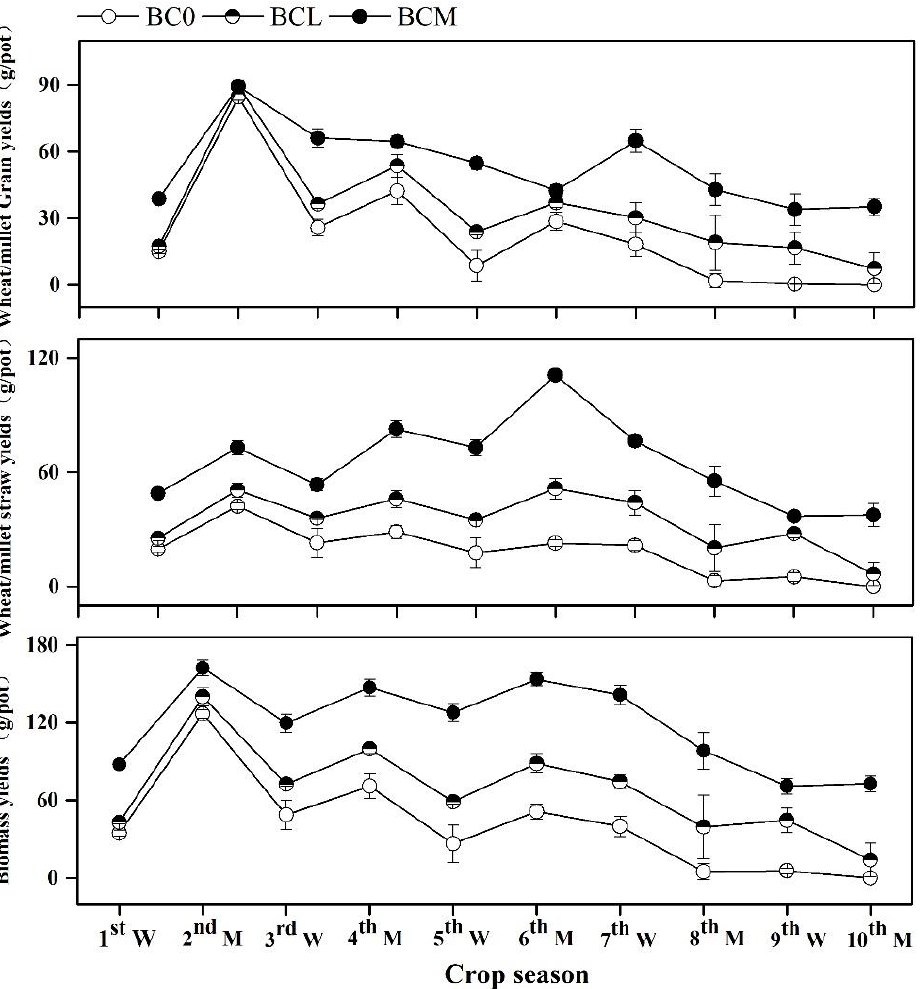
Figure 6. The yields of grain, straw, and biomass of wheat/millet in red soil affected by successive applications of straw biochar during 10 consecutive wheat/millet growing seasons from 2010–2015. Error bars are standard deviations.